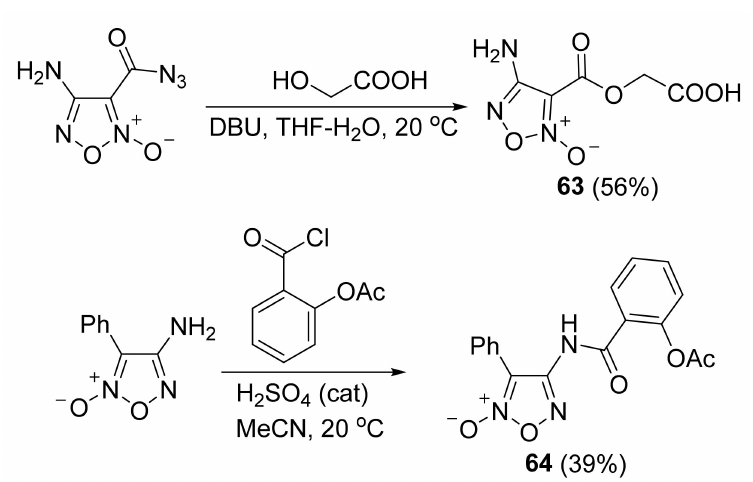
Scheme 32. Synthesis of furoxan-based antiplatelet